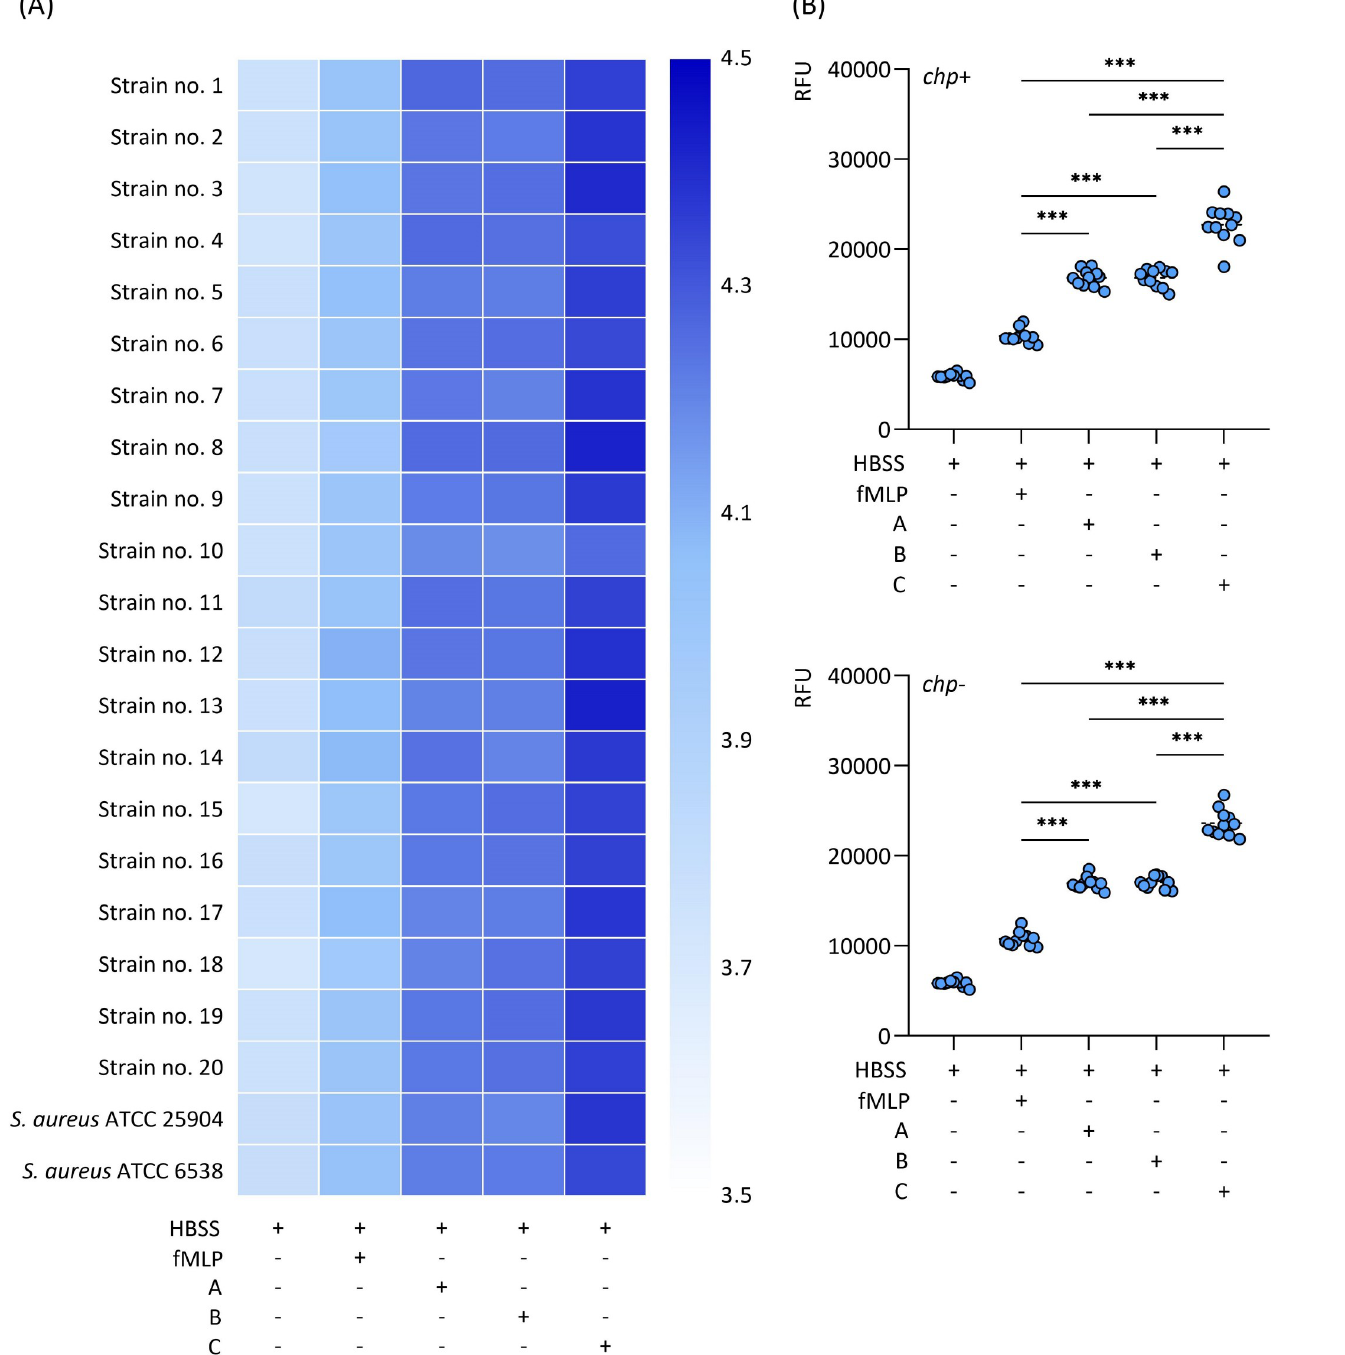
PLOS ONE | https://doi.org/10.1371/journal.pone.0284042 April 7,